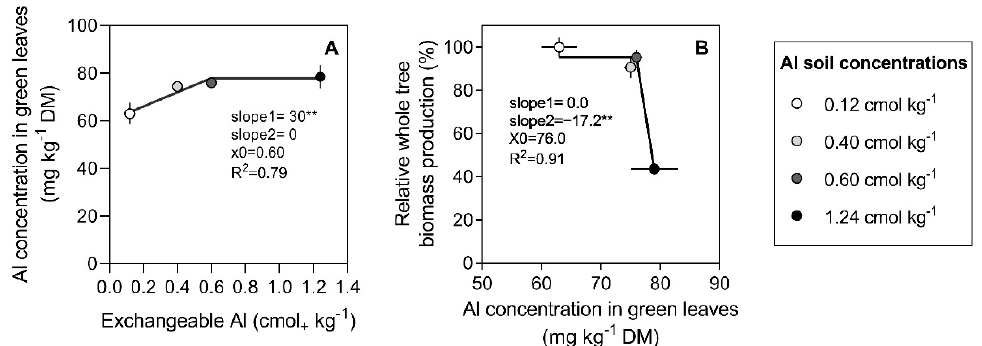
Figure 8. Relationship between ( A ) Al concentration (in dry weight) in green leaves and ( B ) relative biomass production of sweet cherry trees and exchangeable Al in a volcanic soil during the second season after planting. Significance of slopes: ** p < 0.01. In segmental regression, slope1 is the slope of the first line segment, slope2 is the slope of the second line segment, and X0 is the X value where the two line segments intersect.